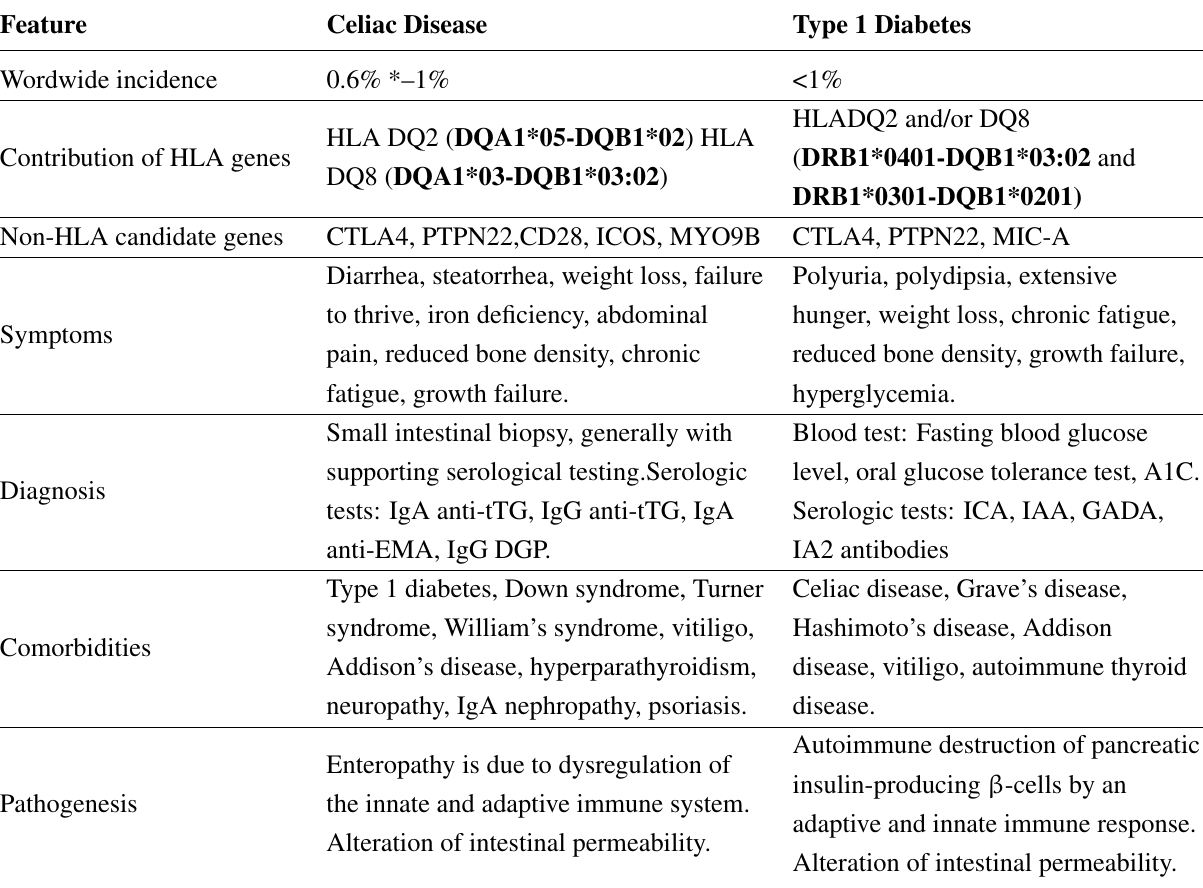
Table 1. Main features of celiac disease and type 1